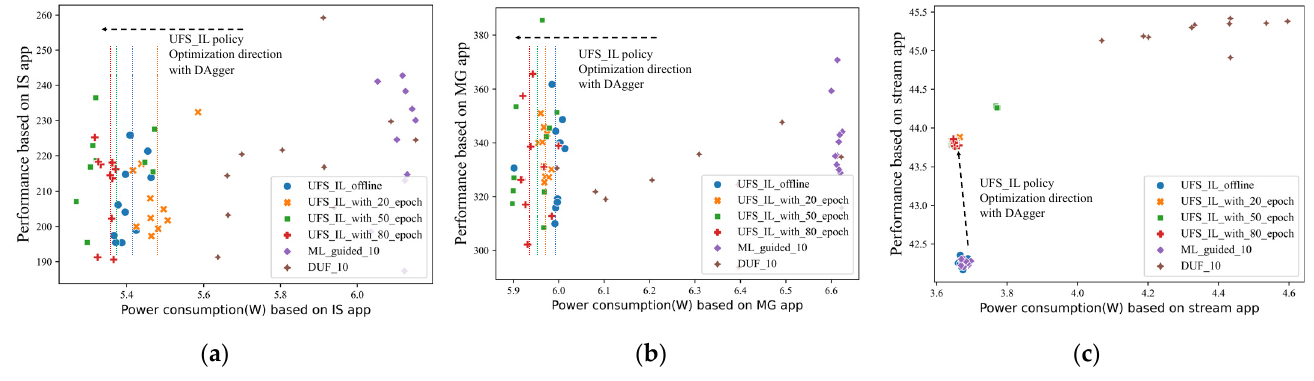
Figure 8. Performance and power consumption data distribution for unseen benchmark apps with different advanced UFS policies and UFS_IL policies with different amounts of aggregation data: ( a ) IS app in NPB; ( b ) MG app in NPB; ( c ) stream.